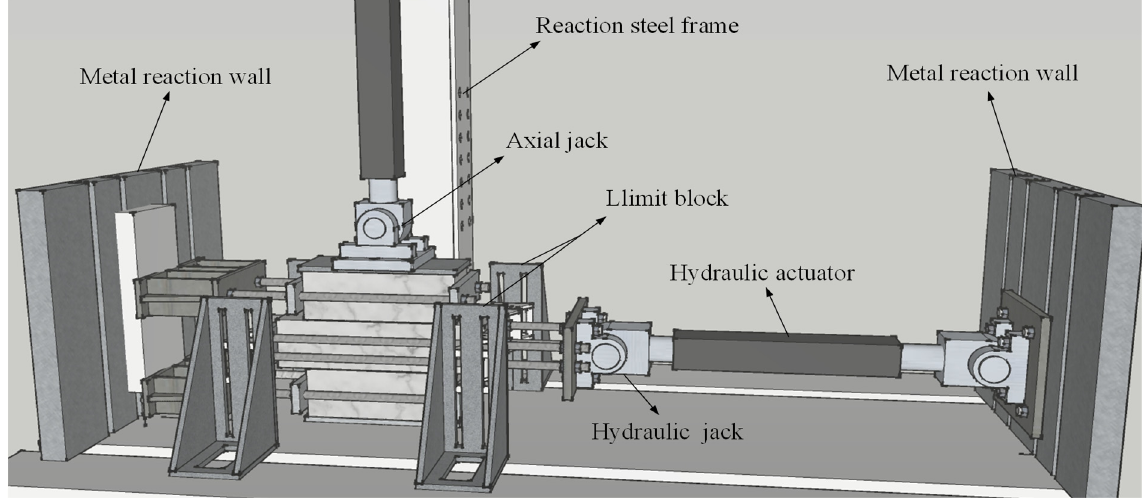
Figure 6. Details of testing rig.